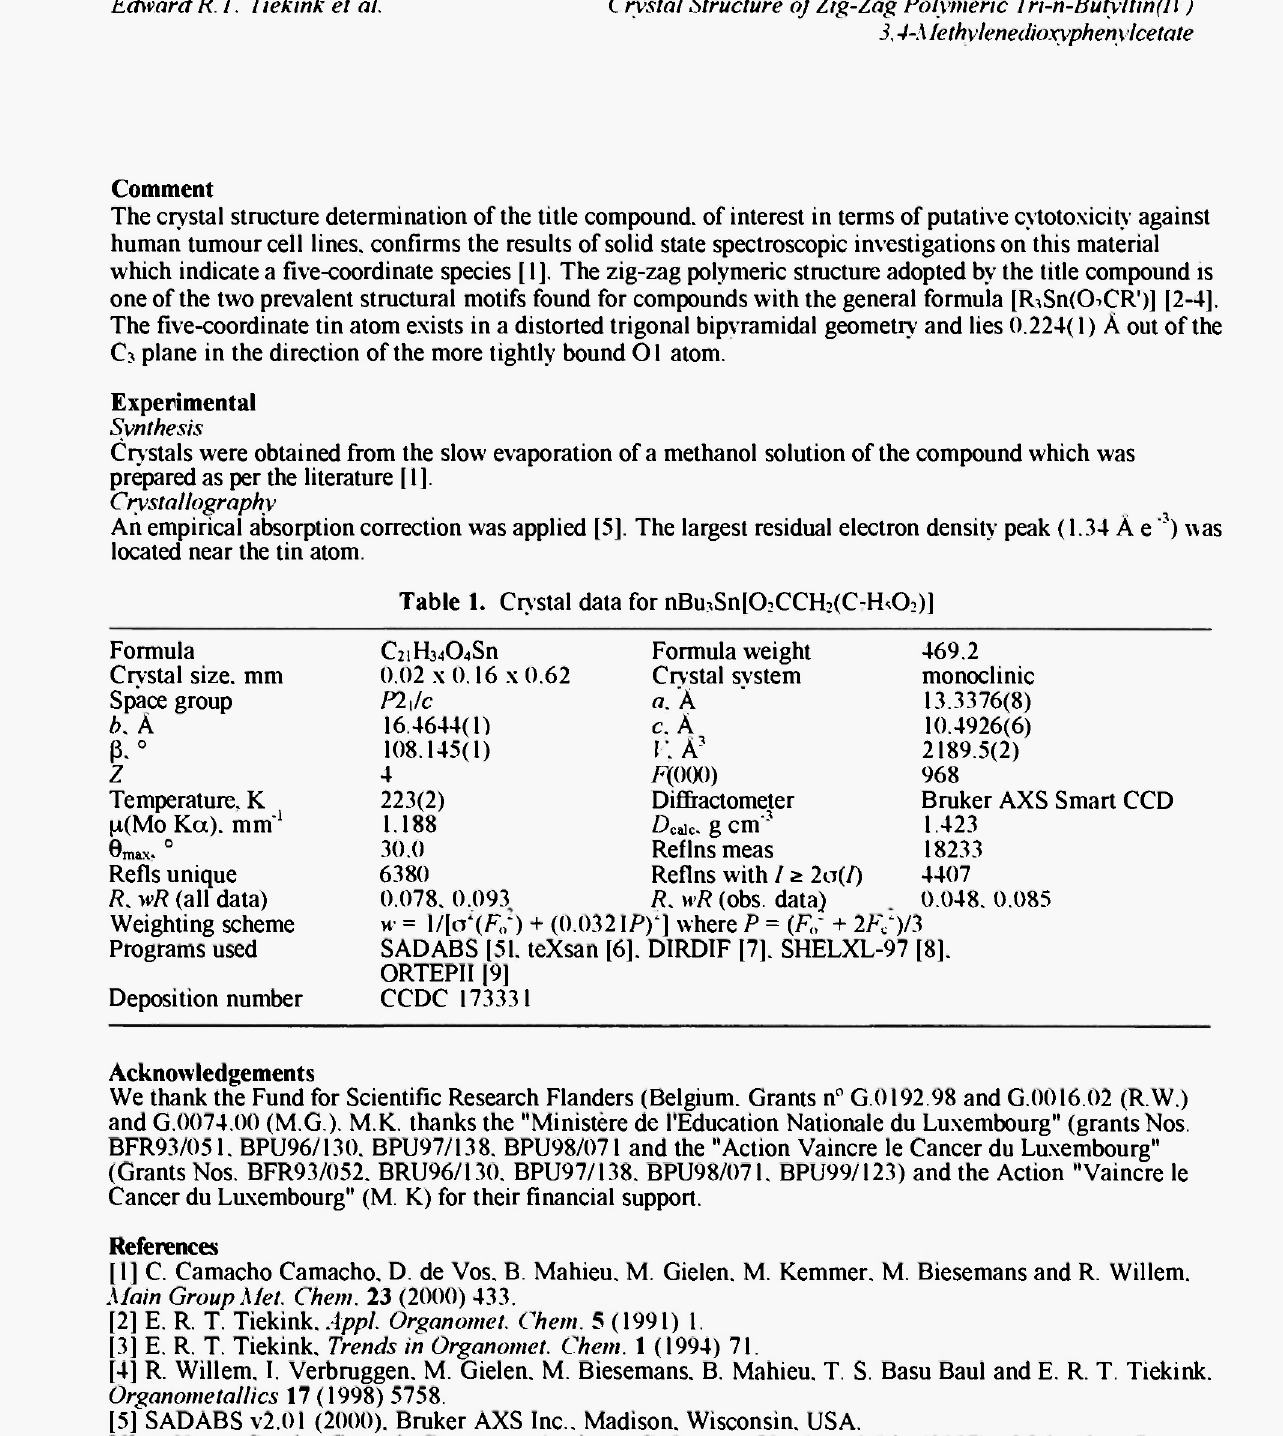
Table 1. Crystal data for